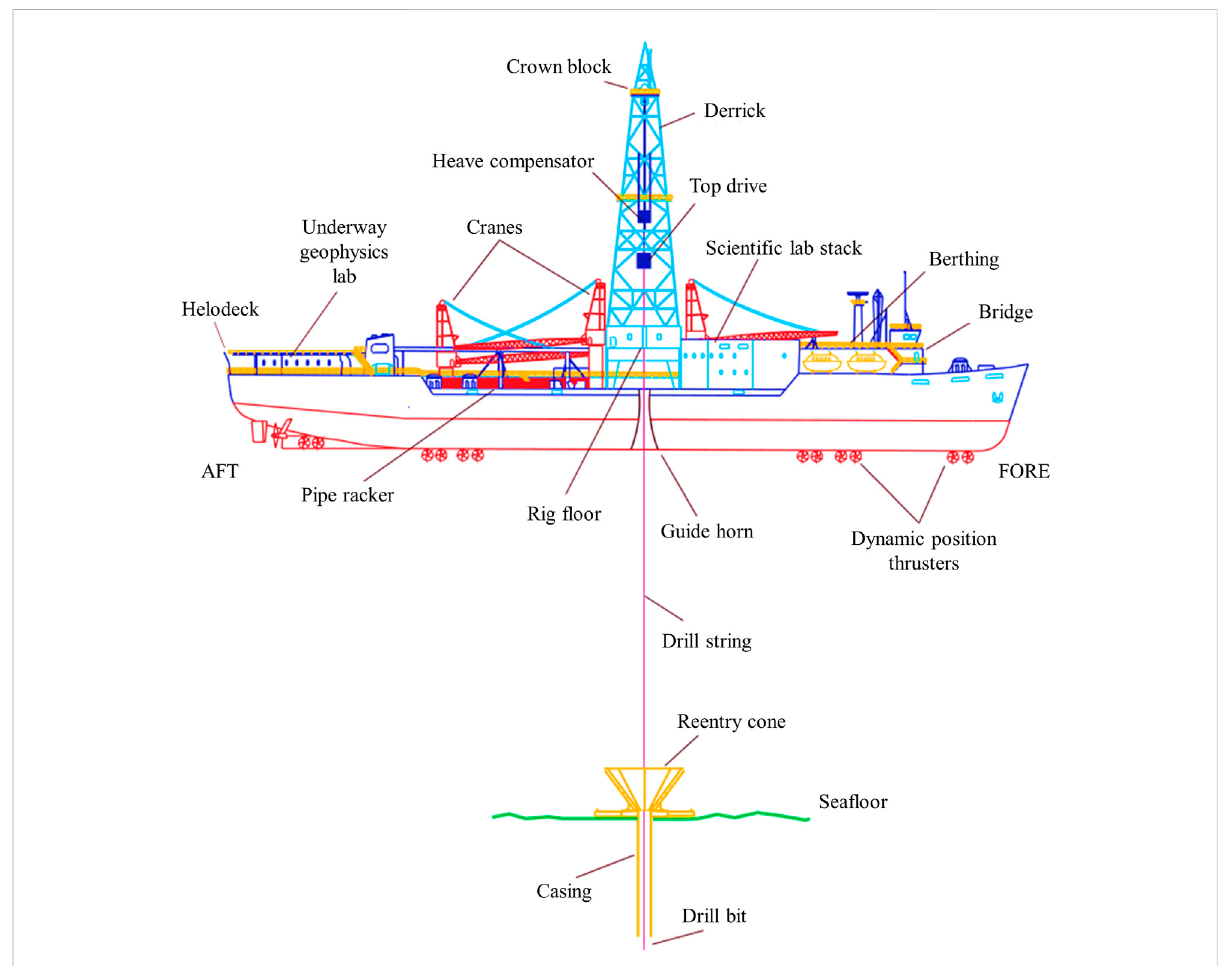
FIGURE 7 Schematic diagram of drilling equipment on R/V JOIDES Resolution (reproduced from (Graber et al., 2021)).